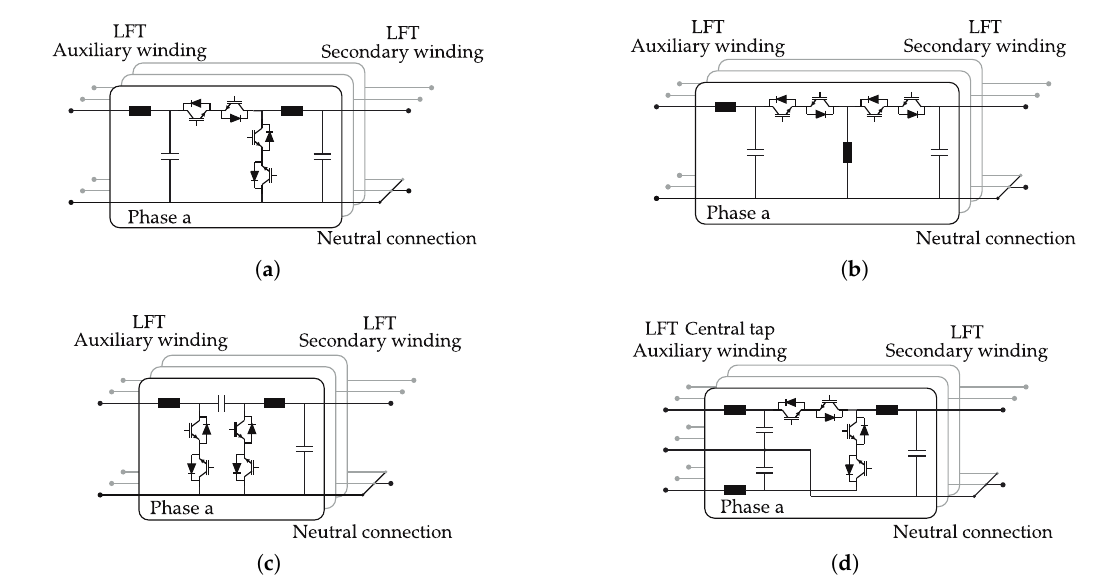
Figure 7. Single-phase representation AC choppers. ( a ) AC buck converter. ( b ) AC buck-boost converter. ( c ) AC ´Cuk converter. ( d ) AC bipolar buck converter.